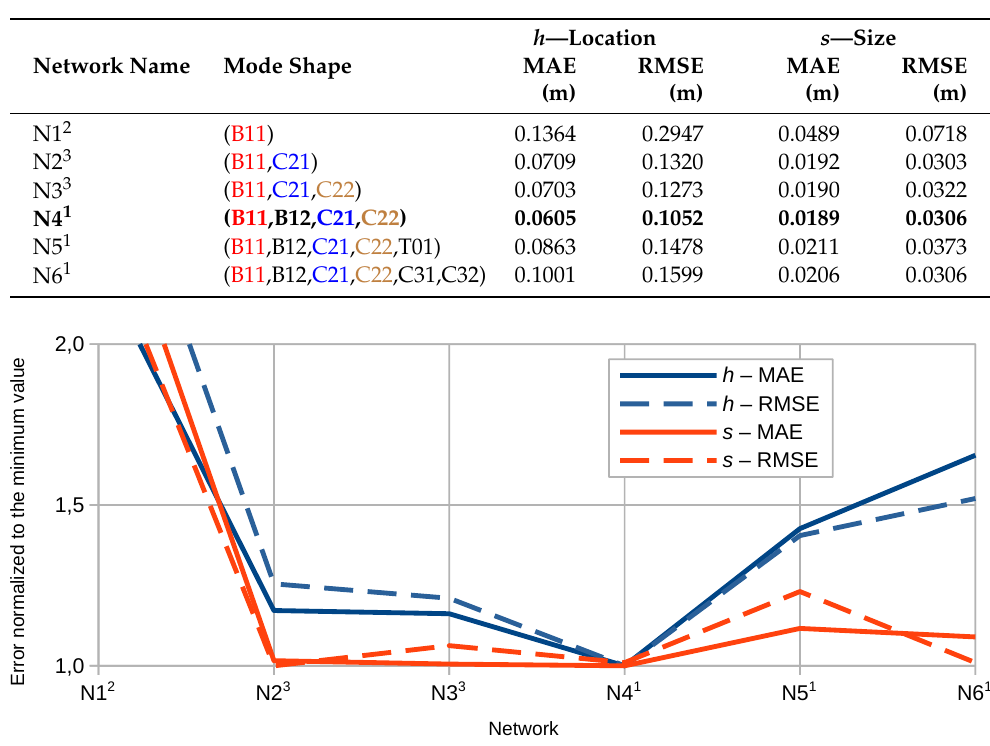
Figure 5. The results of the identification of location h and size s using different numbers of mode